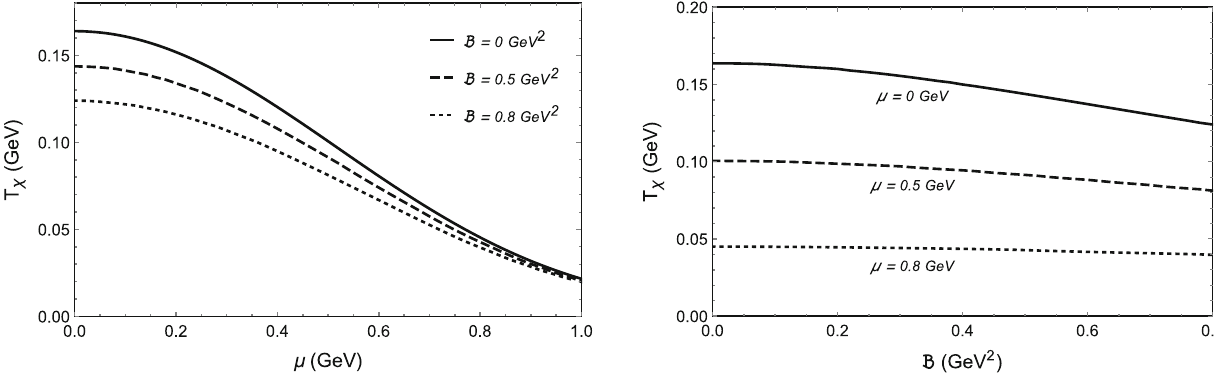
Fig. 2 The μ − T χ phase diagram at B = 0 , 0 . 5 , 0 . 8 GeV 2 (left panel) and the B − T χ phase diagram at μ = 0 , 0 . 5 , 0 . 8 GeV (right panel)